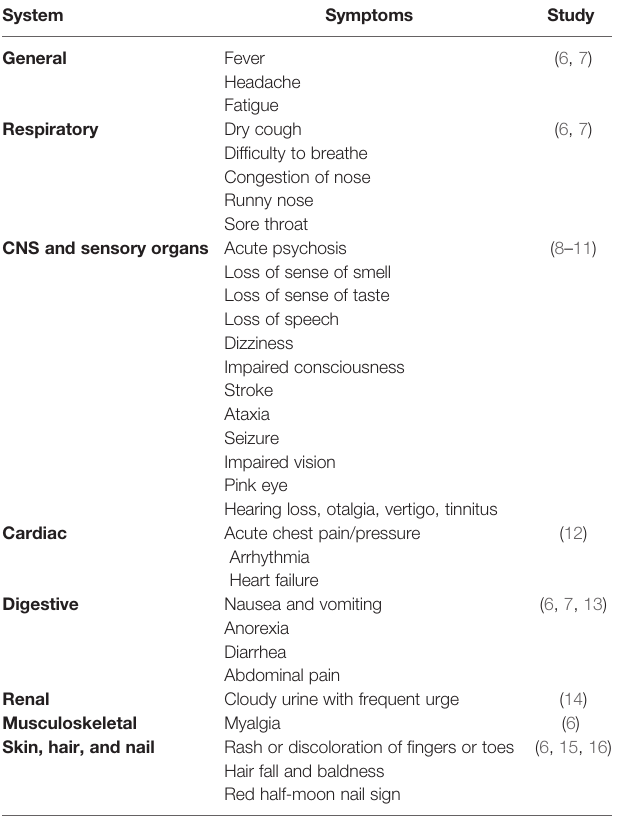
TABLE 1 | Systemic diversity of clinical manifestations in coronavirus disease 2019